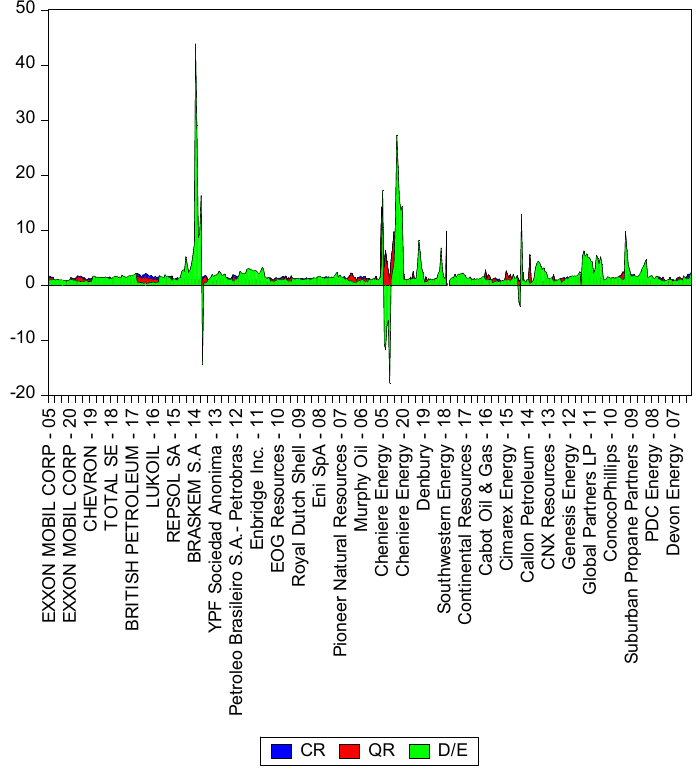
Mathematics 2021 , 9 , x FOR PEER REVIEW Figure 3. Evolution of equilibrium indicators for oil companies. Figure 3. Evolution of equilibrium indicators for oil companies.